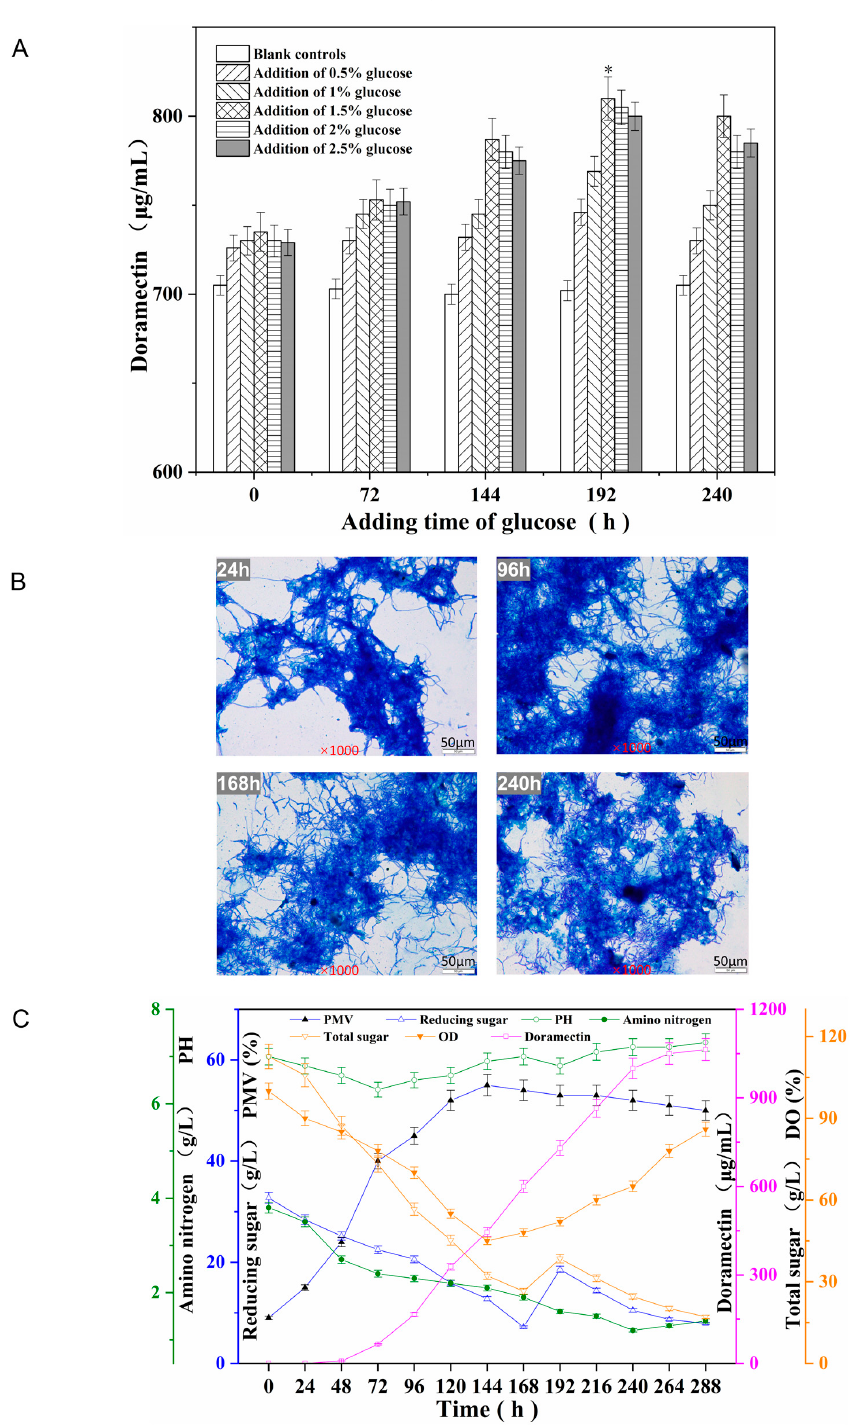
Figure 5. Fermentation of high-yielding strain XY-62 with increased glucose amount and culture in a 50 L fermenter. ( A ) effect of glucose supplementation on the yield of doramectin synthesis by XY-62 (* represents p < 0.05), ( B ) mycelial morphology of XY-62 at different growth periods in the 50 L fermenter, ( C ) growth and metabolic curves of XY-62 in 50 L